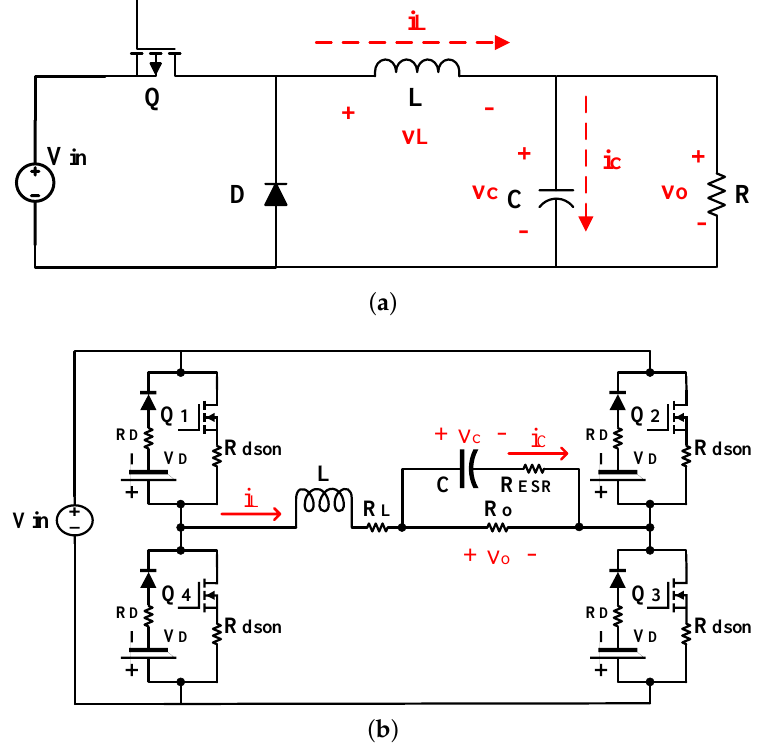
Figure 2. Power converter topologies with two different levels of complexity; ( a ) Ideal dc/dc Buck converter, ( b ) Full-bridge converter with